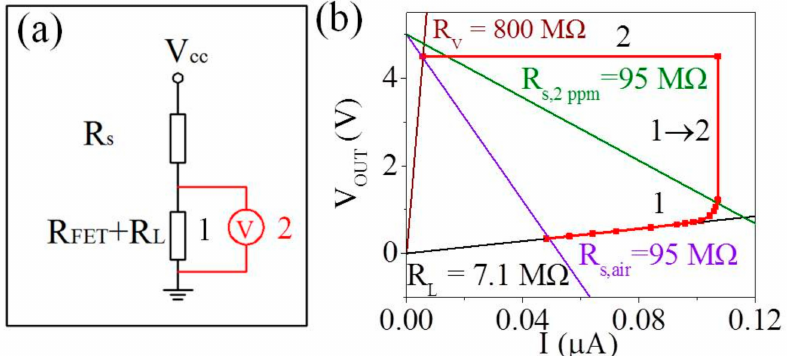
Figure 7. ( a ) Circuit schematic of the static gas sensing test system ( b ) The approximate output voltage of the interlocking p+n FET circuit with R L of 7.1 M Ω (red solid